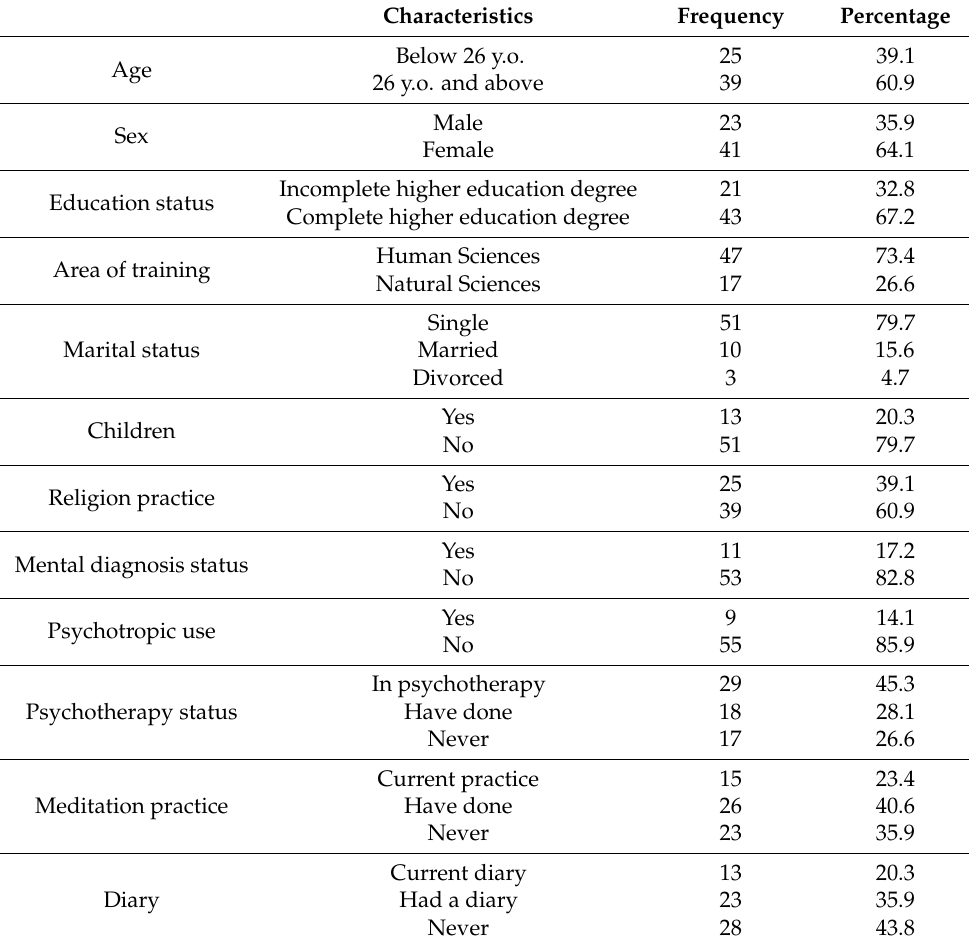
Table 2. Sociodemographic characteristics and mental health information. n = 64. Characteristics Frequency Percentage Below 26 Age